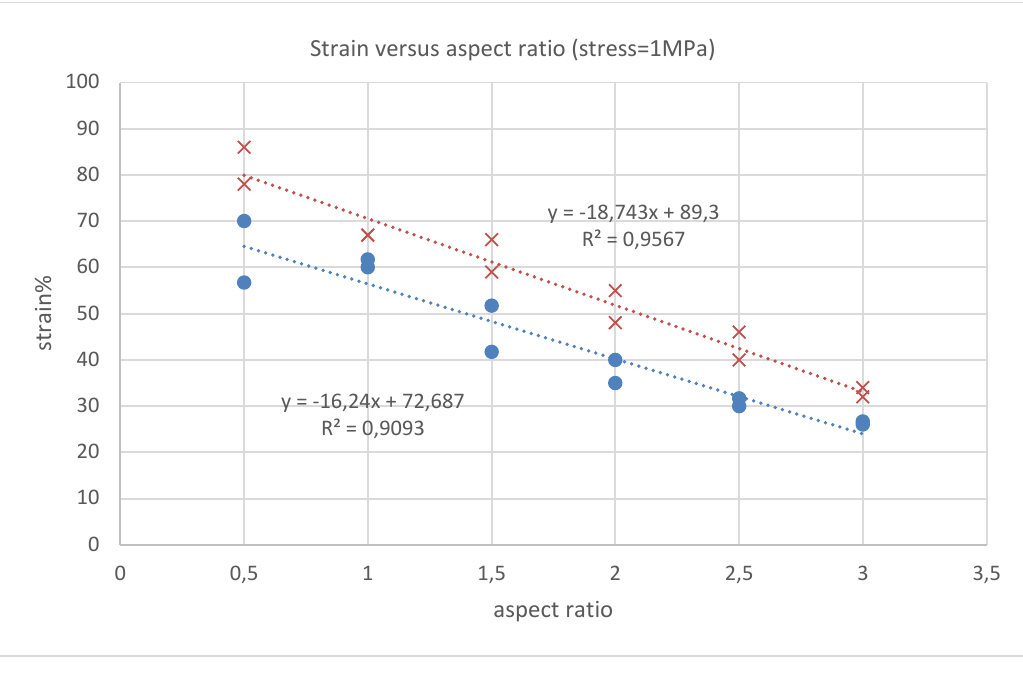
Fig. 5: strain versus aspect ratio (at stress= 1MPa) for both experimental (  ) and modelled data ( 